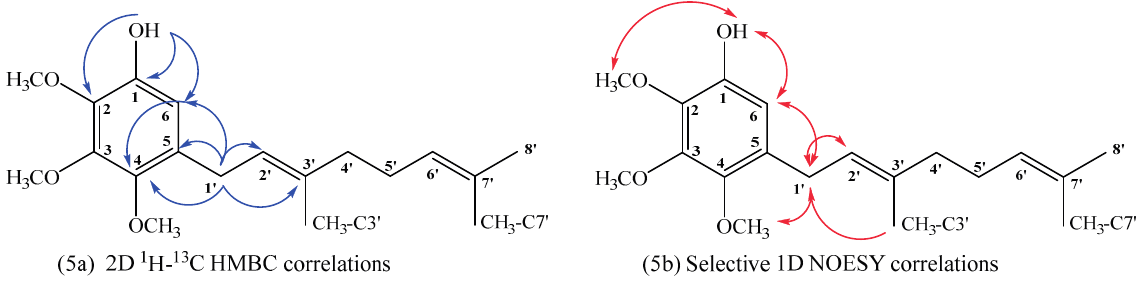
Figure 5. Main correlations observed for compound 18 , 2D 1 H– 13 C HMBC ( 5a ), selective 1D NOESY ( 5b ).